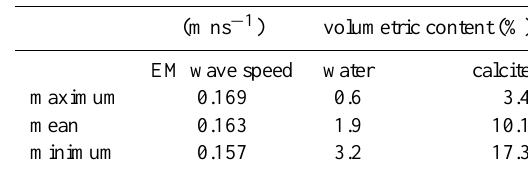
Table 2. Liquid water and calcite content calculated from the ob- served EM wave speed and the mean density from the ice core at the location